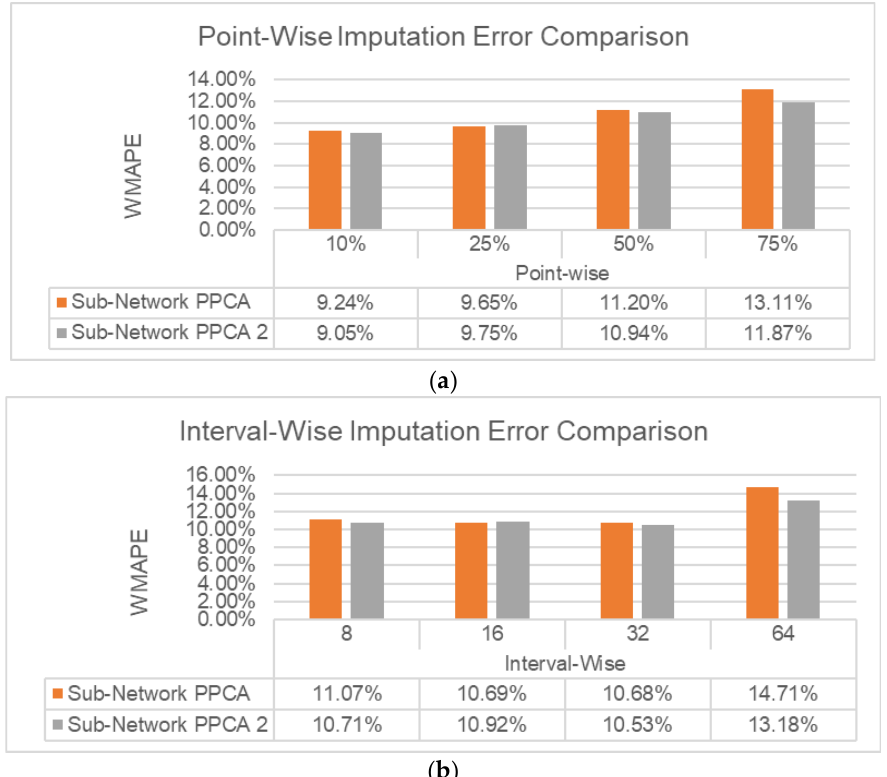
Figure 14. Imputation error comparison between Sub-Network PPCA and Sub-Network PPCA 2 for ( a ) point-wise missing data and ( b ) interval-wise missing data. Table 2. Imputation error of each vehicle detector in Diponegoro neighborhood for 10% point-wise missing data and 8 interval-wise missing data. Vehicle Detector 4-1 is considered an outlier, as it has huge imputation error compared to other links.